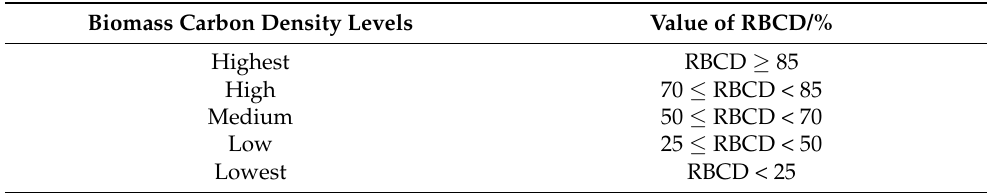
Table 2. Biomass carbon density classification